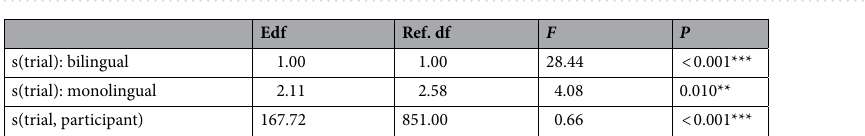
Table 2. Approximate significance of smooth terms (outcome variable: proportion of time looking at the changing stimulus). Parametric coefficients: intercept = 0.55 ( SE = 0.01, t = 46.93, p < 0.001); monolingual = − 0.06 ( SE = 0.02, t = 2.52, p = 0.012). GCV = 0.04, adjusted R 2 = 0.27, deviance explained = 34.1%. ** p < 0.01, *** p < 0.001.